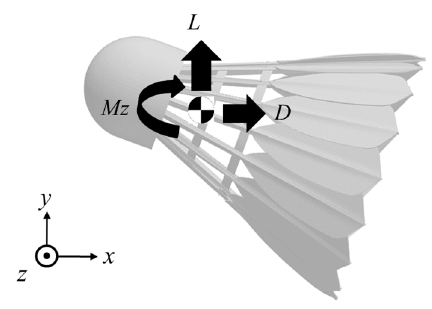
Figure 2. Coordinate system.